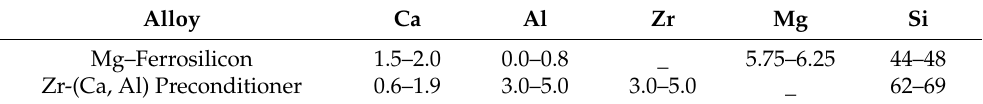
Table 1. Chemical composition (wt.%) of Mg-Ferrosilicon and preconditioner used. Fe is balance.